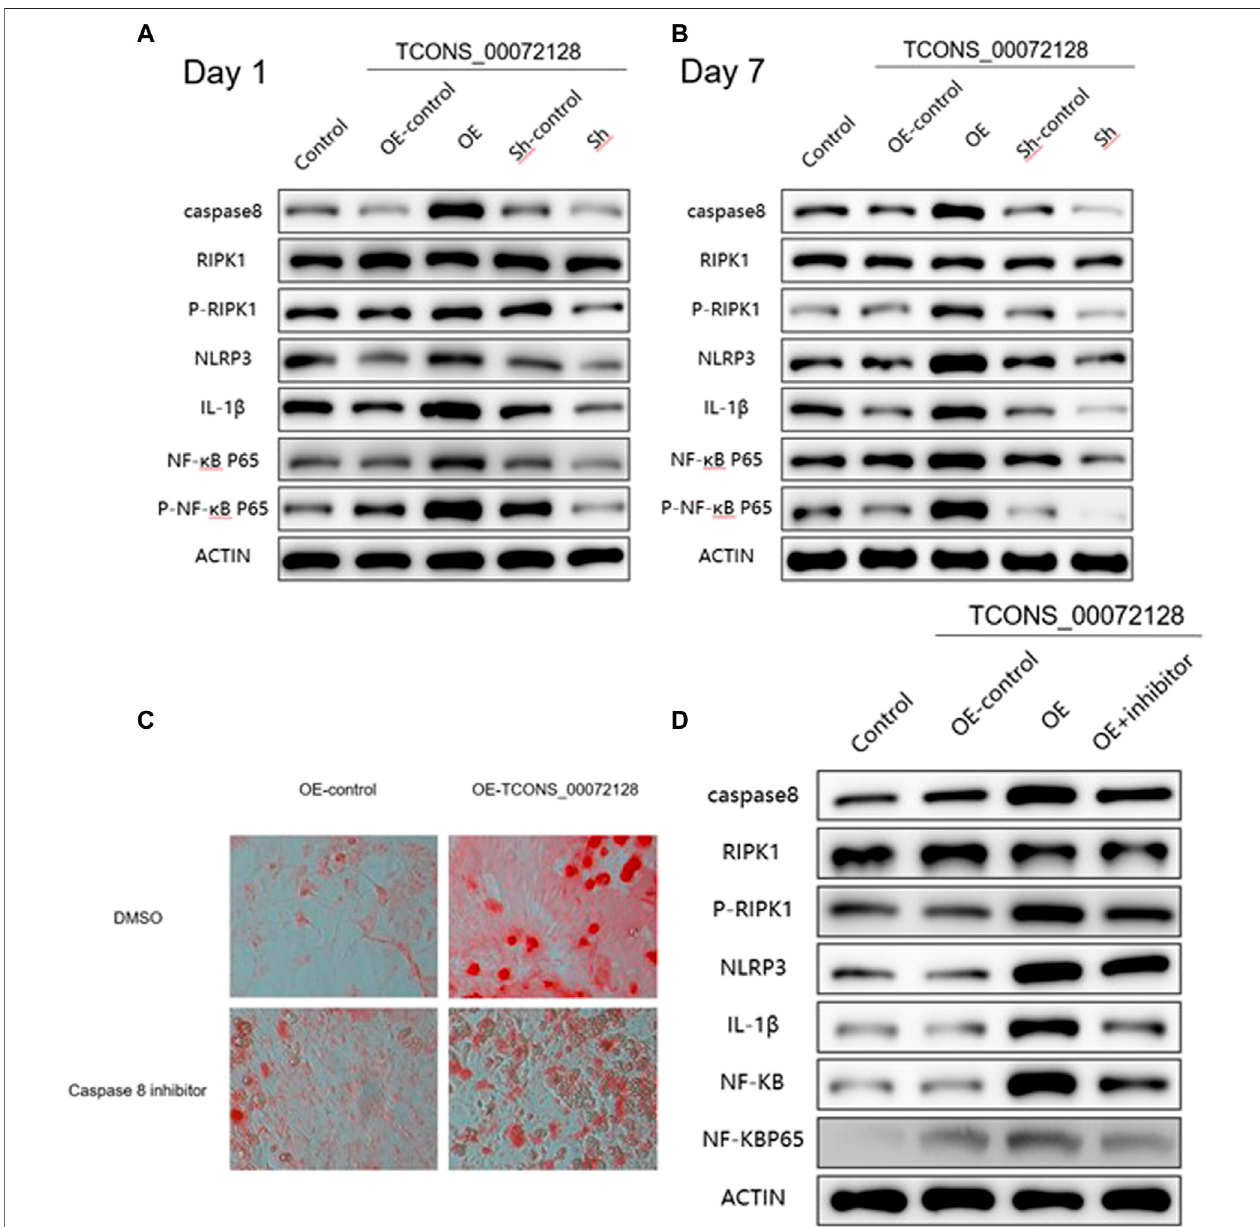
FIGURE 5 | caspase 8 expression regulates osteogenic differentiation and occurrence of in fl ammation via multiple pathways. (A – B) Western blot analysis with caspase 8, RIPK1, p-RIPK1, NLRP3, IL-1 β , NF- K B P65 and p-NF- K B P65 extracted from BMSCs treated with lentivirus infection and were induced by osteogenic medium for 1 and 7 days individually. (C) ARS staining and (D) Western blot analysis for caspase 8 associated proteins extracted from BMSCs treated with lentivirus infection and caspase 8 inhibitor Z-IETD-FMK for 7 days. All results are presented with three replicates. * p ≤ 0.05, *** p ≤ 0.001.